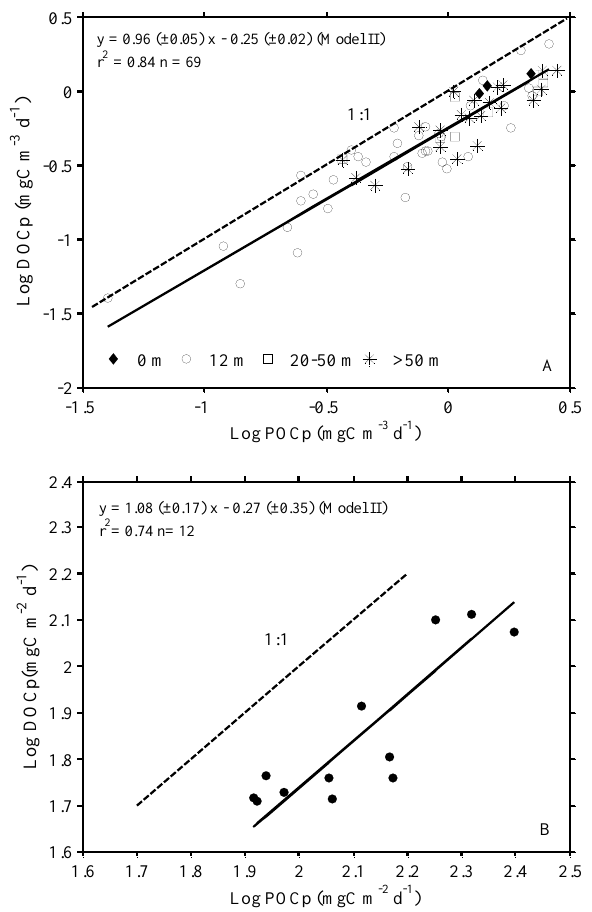
Figure 4. Log-log relationship between particulate (POCp) and dissolved organic carbon production (DOCp) with all pooled A) volumetric and B) euphotic layer-integrated measurements. In both A) and B), the slope of the regression line was not significantly different from 1 (Clarke test, P = 0.42 and 0.97 for volumetric and integrated data, respectively).